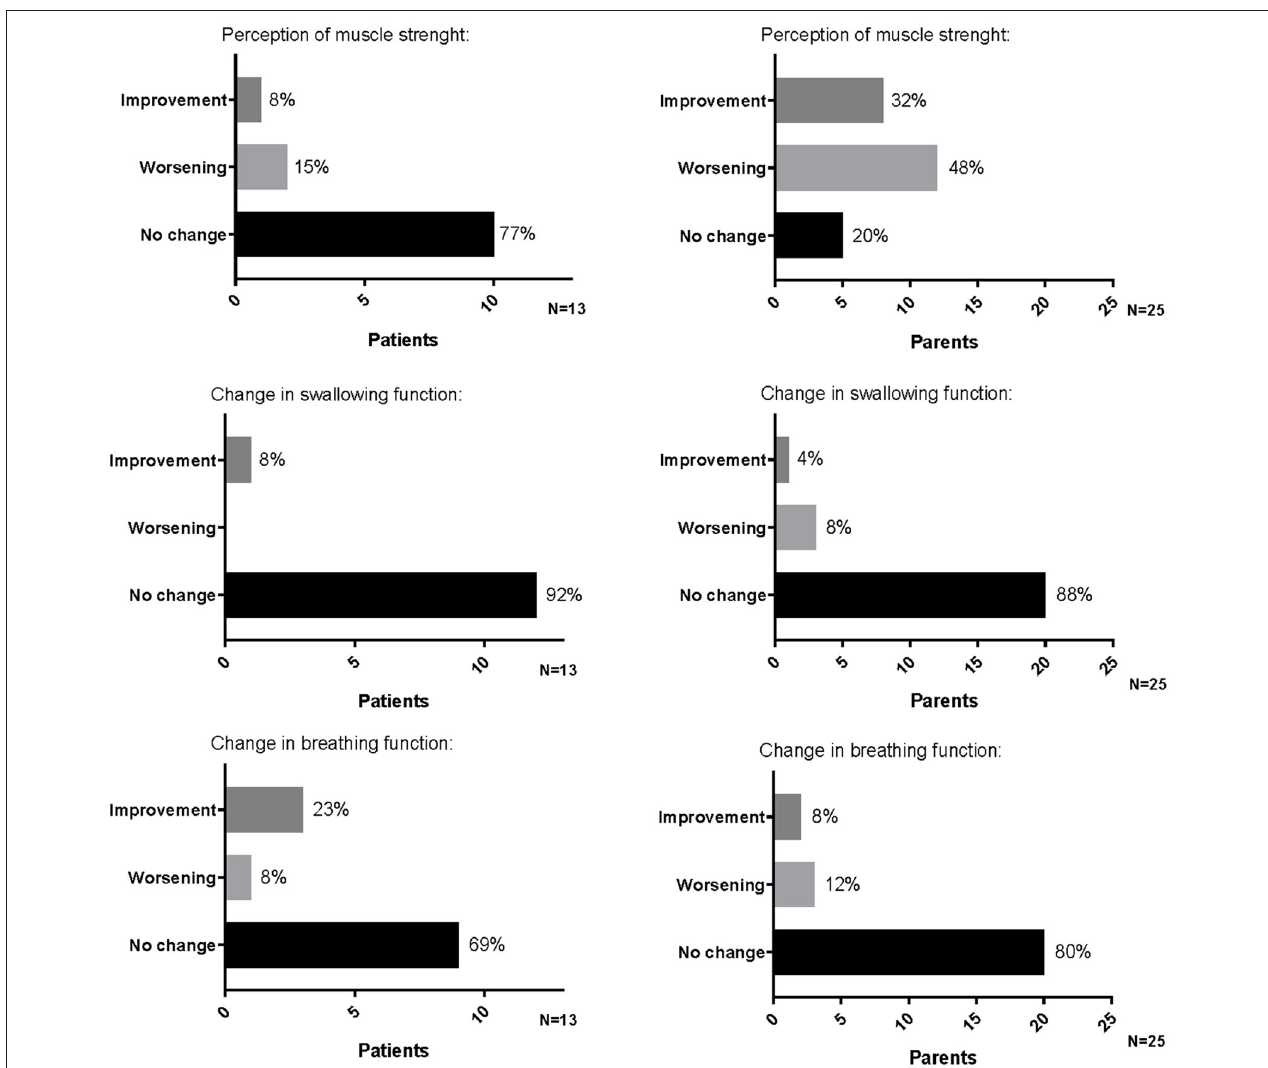
FIGURE 1 | Perception of muscle strength, swallowing, and breathing functions reported by patients and parents on the occasion of the first administration of therapy after the temporary